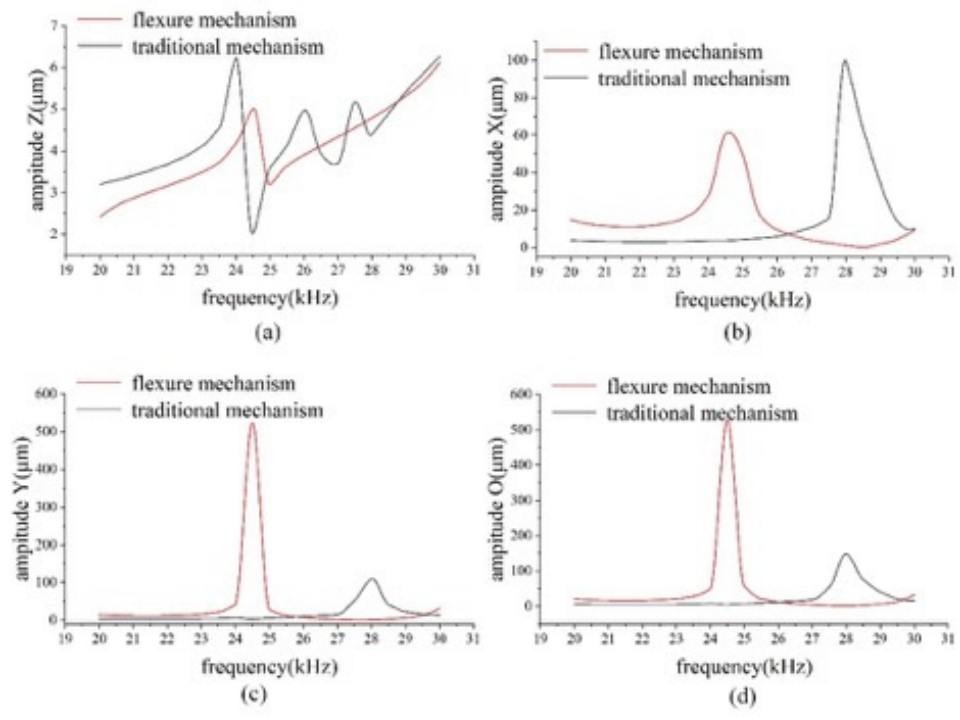
Figure 4. Harmonic response analysis of the needle tip vibration of the microdissection device: ( a ) The frequency response curve of the vibration amplitude in the axial Z direction of the two models; ( b ) the frequency response curve of the vibration amplitude in the lateral X direction of the two models; ( c ) frequency response curve of the vibration amplitude in the lateral Y direction of the two models; ( d ) the frequency response curve of the overall vibration amplitude of the two models.